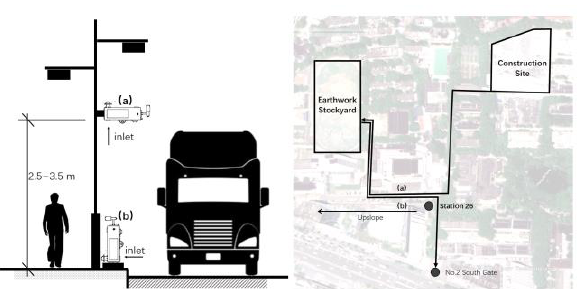
Figure 7 . Left: The installation of (a) a typical road side station, and (b) Station 26 in the muck truck experiment. Right: Surrounding environment of the much truck experiment. (a) Truck path from construction site to the stockyard; (b) Truck path from the stockyard to outside the campus.